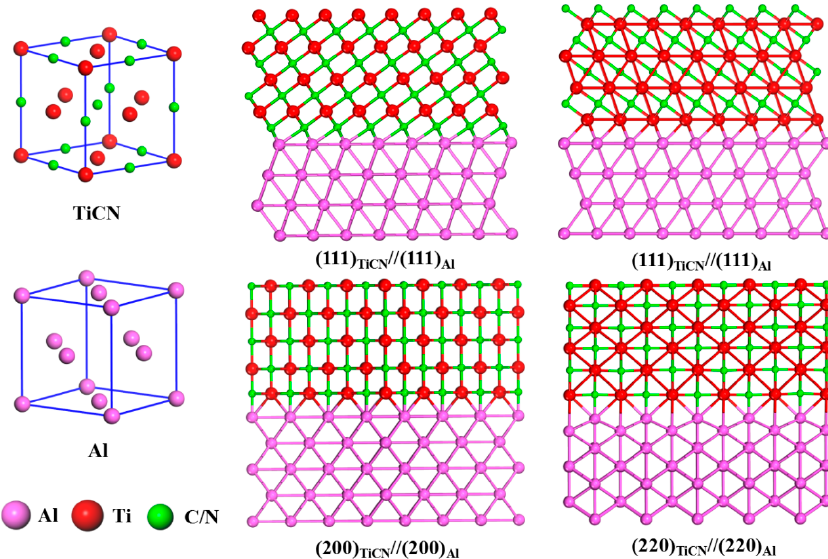
Figure 6. Interface structures of the Al matrix and TiCN nanoparticles. Table 1. Possible orientation relationships between TiC 0.5 N 0.5 and Al.